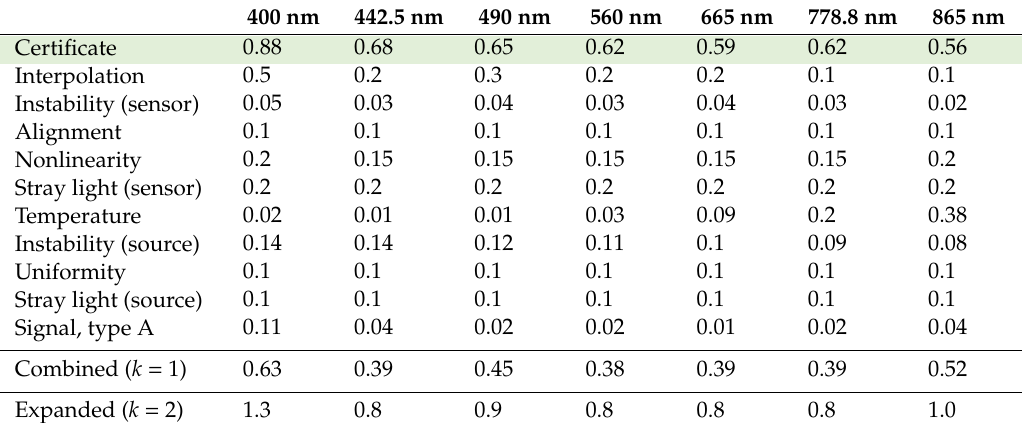
Table 3. Relative uncertainty budget for the irradiance (in percent), based on spread of individual sensors measuring the same lamp during indoor comparison. Data highlighted in green are not used for combined and expanded uncertainties.